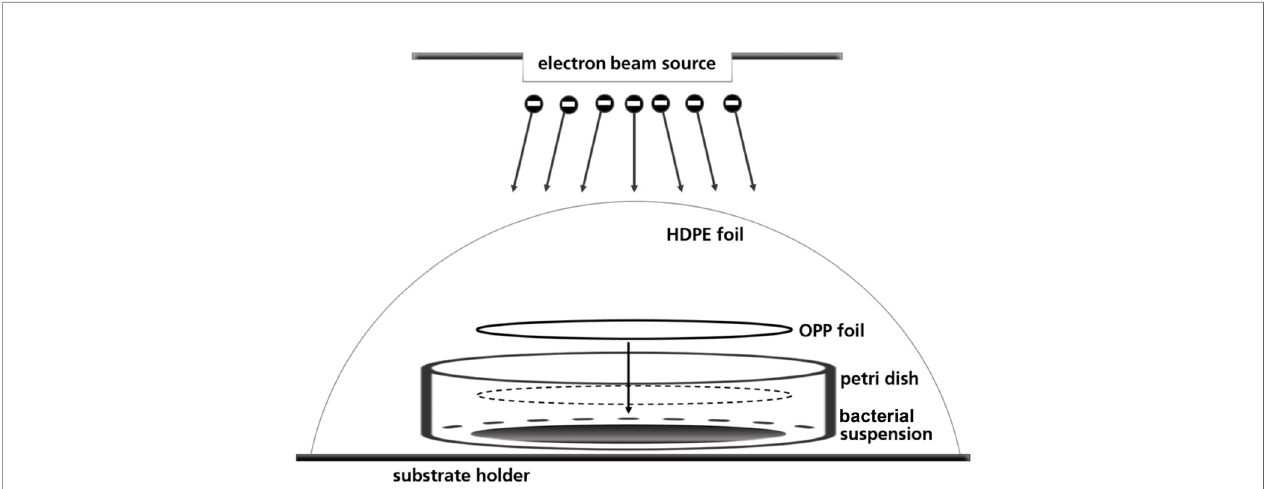
FIGURE 1 | Schematic illustration of the OPP-system used for the irradiation of the bacterial